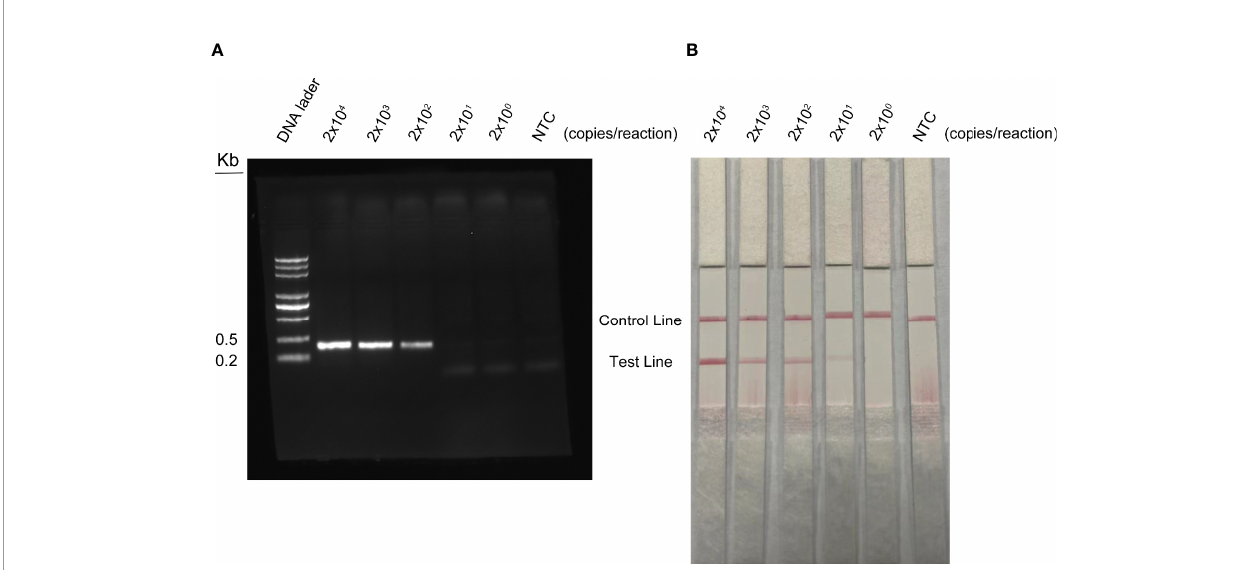
FIGURE 7 | Detection limit of RPA-LFS reaction. One microliter of WSSV (2 × 10 7 to 2 × 10 3 copies/ml) was used as a template and reacted at 37°C for 30 min. (A) The result of the agarose gel electrophoresis. (B) The result of the LFS analysis. The amount of WSSV is shown at the top of each strip. NTC was a template-free negative